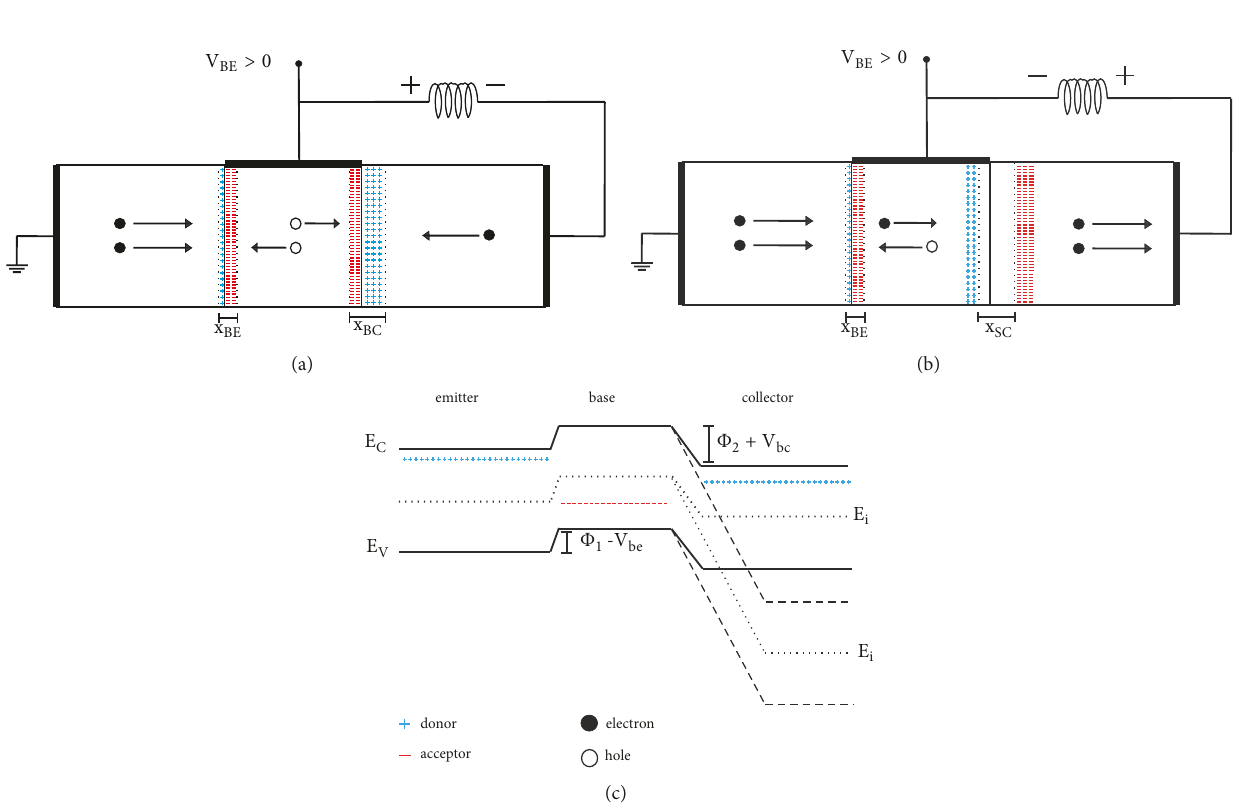
Figure 9: Transistoractiondependenton ionized impurities. (a)Displacementof thecharge carries atinductorpolarity ( ± ). (b)Displacement of the charge carries at inductor polarity ( ∓ ). (c) Action in the energy band